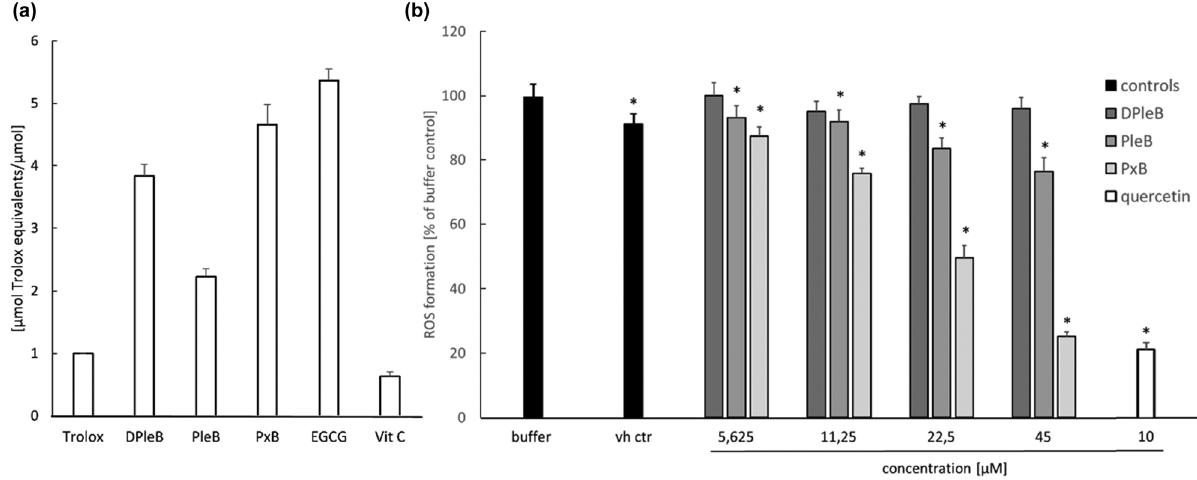
Figure 2: Antioxidative potency of di ff erent phyllobilins. ( a ) In vitro : ORAC assay. Phyllobilins are compared to the scavenging potential of Trolox ( a water soluble vitamin E derivative ) . Relative ORAC values are shown as µmol Trolox equivalent/µmol test substance. Mean values of four replicates ( each in duplicates ) are shown ( two replicates in duplicates for vitamin C [ Vit C ]) . Error bars represent standard error of the mean ( SEM ) . EGCG, epigallocatechingallate. ( b ) In cellulo : CAA assay. Formation of ROS in CaCo - 2 cells was induced by a radical generator ( AAPH ) ; cells were treated with quercetin ( 10 µM ) or increasing concentrations of phyllobilins ( DPleB, PleB, PxB ) , or vehicle control ( vh ctrl, 0.2 % ( v/v ) EtOH in HBSS bu ff er ) . The read - out was fl uorescence of DCF. Mean values of at least three independent experiments are shown. Error bars represent standard error of the mean ( SEM ) . p - Values ≤ 0.05 are marked as signi fi cant. Figure established from data published in Karg et al. [ 4 ]